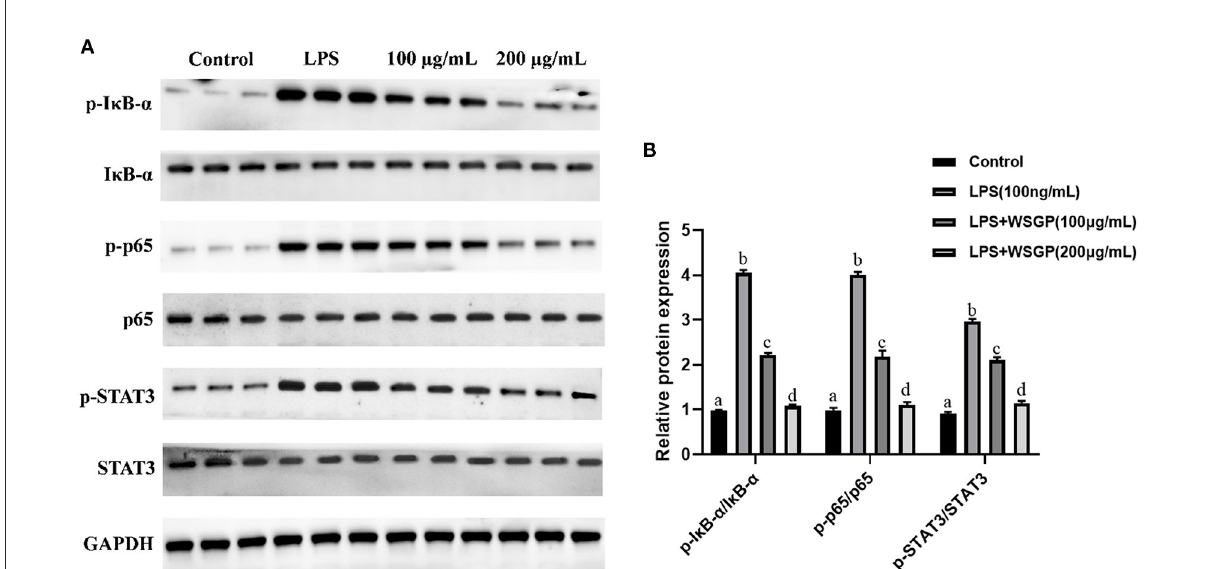
FIGURE7 Inhibitory effect of WSGP on activation of NF- κ B and STAT3 signaling pathways in LPS-induced RAW264.7 macrophages (A) . The data were expressed as means ± SD from three independent experiments (B) . The 100 and 200 µ g/mL groups respectively represented different doses of WSGP intervention while induced by